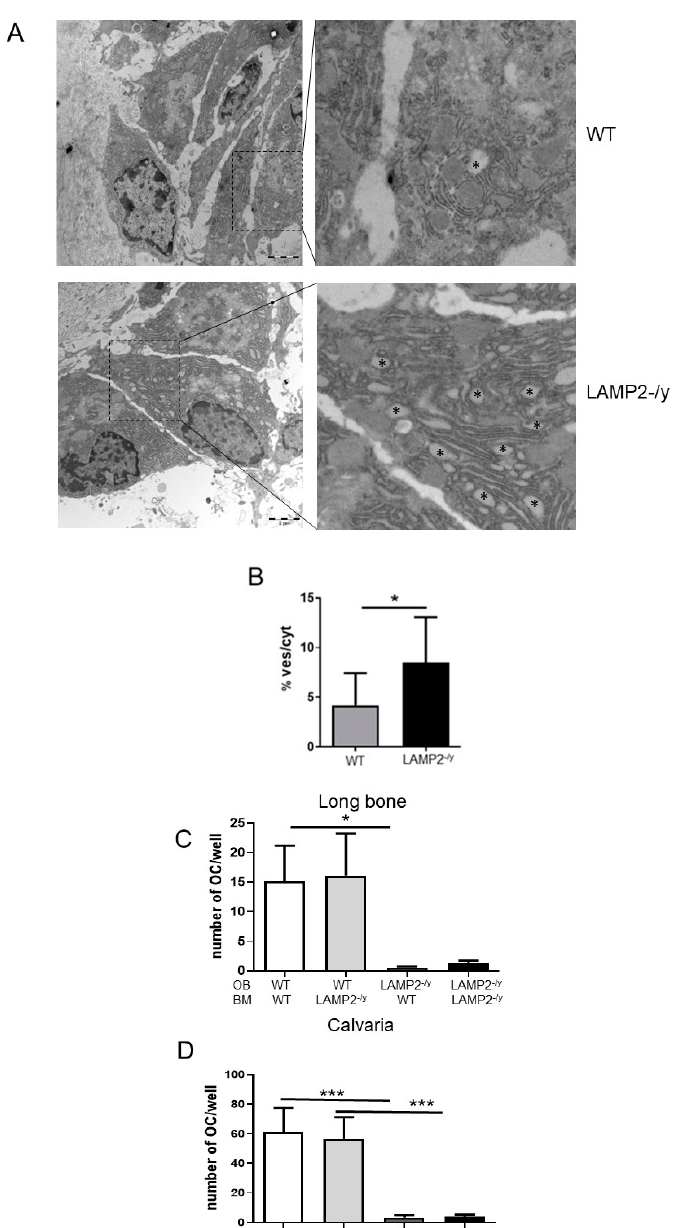
Figure 4. Osteoblasts of LAMP-2 deficient mice have many vacuoles and do not induce osteoclast formation. ( A ) Electron micrographs of WT and LAMP-2- / y osteoblasts. Asterisks indicate vacuoles which are much more abundant in the LAMP-2- / y osteoblasts. ( B ) The number of vacuoles per osteoblast is significantly higher in the LAMP-2- / y osteoblasts compared to WT osteoblasts ( n = 10 ± SD, * p < 0.05). ( C , D ) Osteoblasts (OB) and bone marrow cells from long bone ( C ) and calvaria ( D ) of wild type (WT) and LAMP-2 - / y mice were co-cultured for 10 days. Wild type osteoblasts of both types of bone induced the formation of multinucleated osteoclasts. This occurred with bone marrow cells of both genotypes (WT or LAMP-2- / y). Hardly any osteoclast was generated in the co-cultures with LAMP-2- / y osteoblasts ( n = 9, * p < 0.05, *** p <